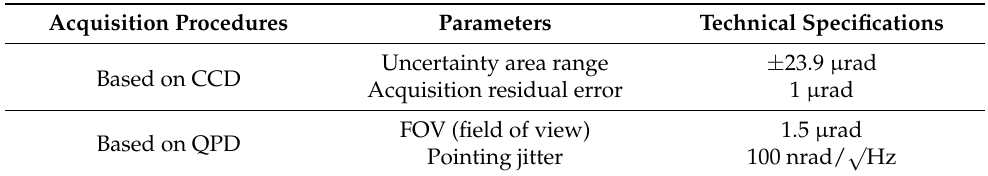
Table 1. Main technical parameters involved in the acquisition procedures based on the CCD and QPD